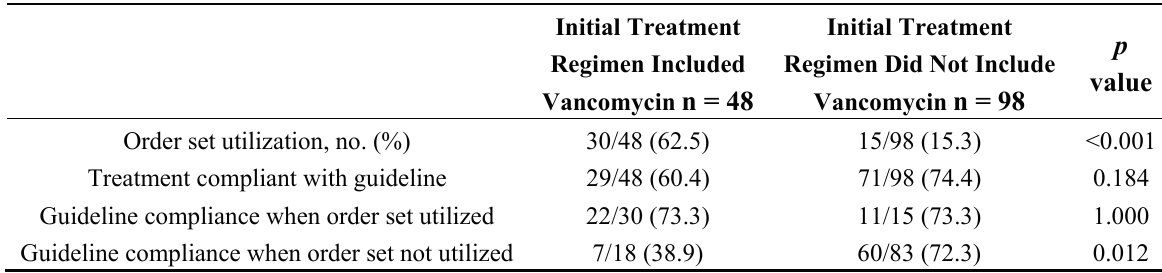
Table 3. Order Set Utilization and Guideline Compliance Based on Initial Antibiotic